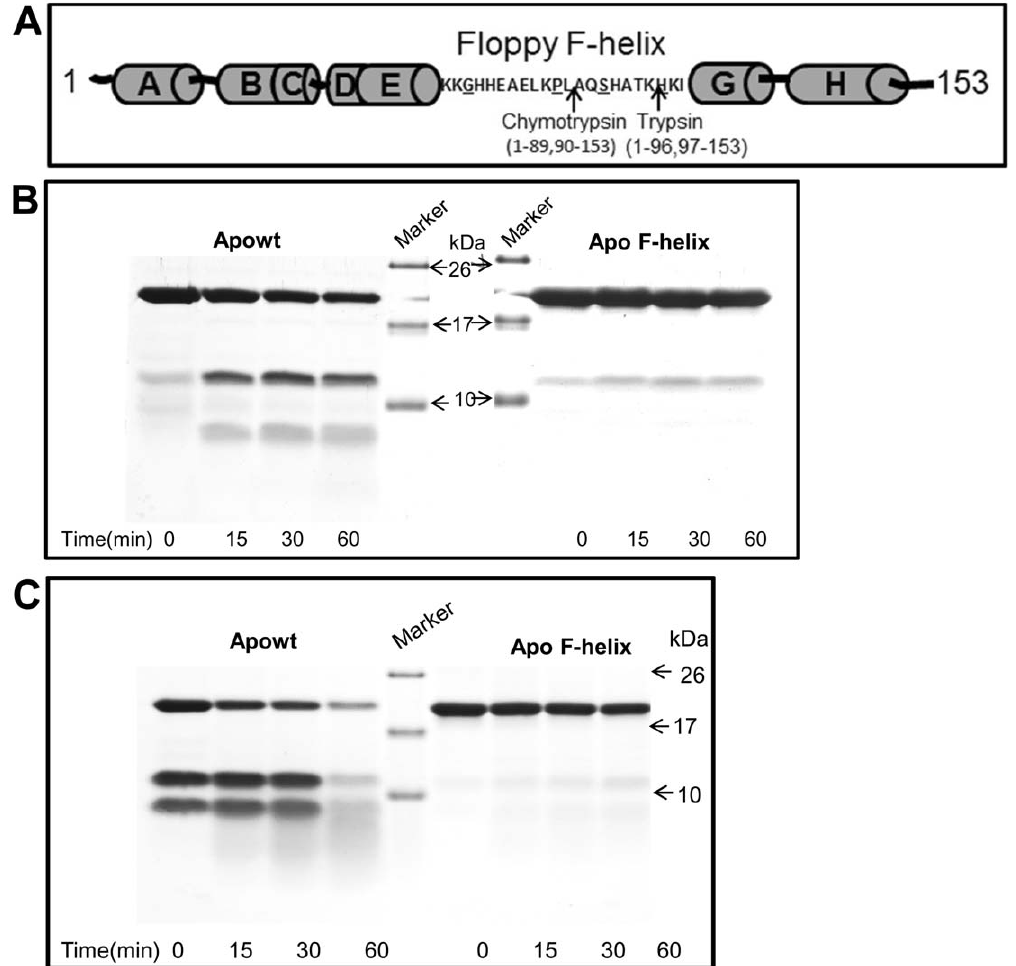
Figure 4. Limited proteolysis demonstrates the presence of an unstable and stable F-helix in wt and F-helix mutant respectively. (A) Cleavage sites of trypsin and chymotrypsin on Mb are diagrammatically represented (in F-helix underlined amino acids are mutated). Trypsin (B) and chymotrypsin (C) were added to wt and F-helix mutant. Aliquots at various time intervals were analyzed by Tricine-SDS Page. Wt protein is cleaved by chymotrypsin as soon as the enzyme is added (0 min). These fragments are not contaminant in the preparation as can be seen from the purity of Mb in Figure 1. Substrate alone controls were stable (data not shown).